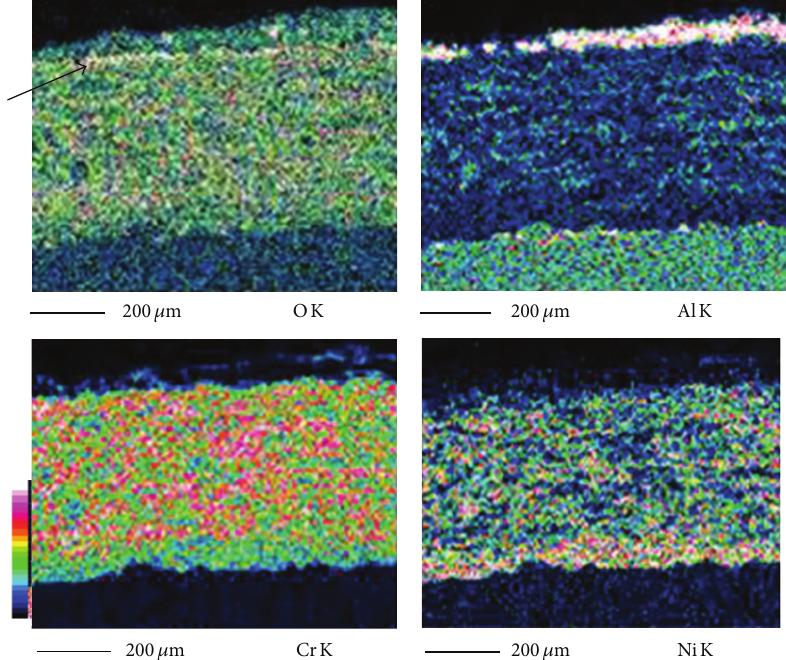
Figure 13: X-ray mapping for the elements of O, Al, Cr, and Ni over the region given in Figure 12(a).